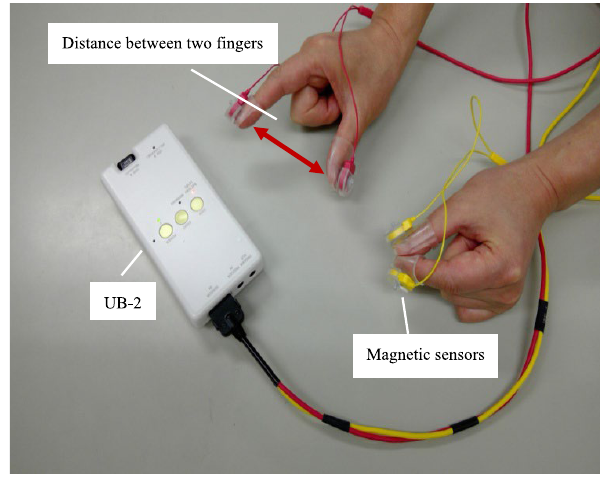
Figure 1 Finger Tapping Device with Magnetic Sensors (UB-2) The yellow cable is attached to the left thumb and index finger, and the red cable is attached to the right thumb and index finger. The main body of the device is connected to a PC, and the wave patterns of the finger tapping can be checked on the PC. It is lighter than UB-1 and is easy to